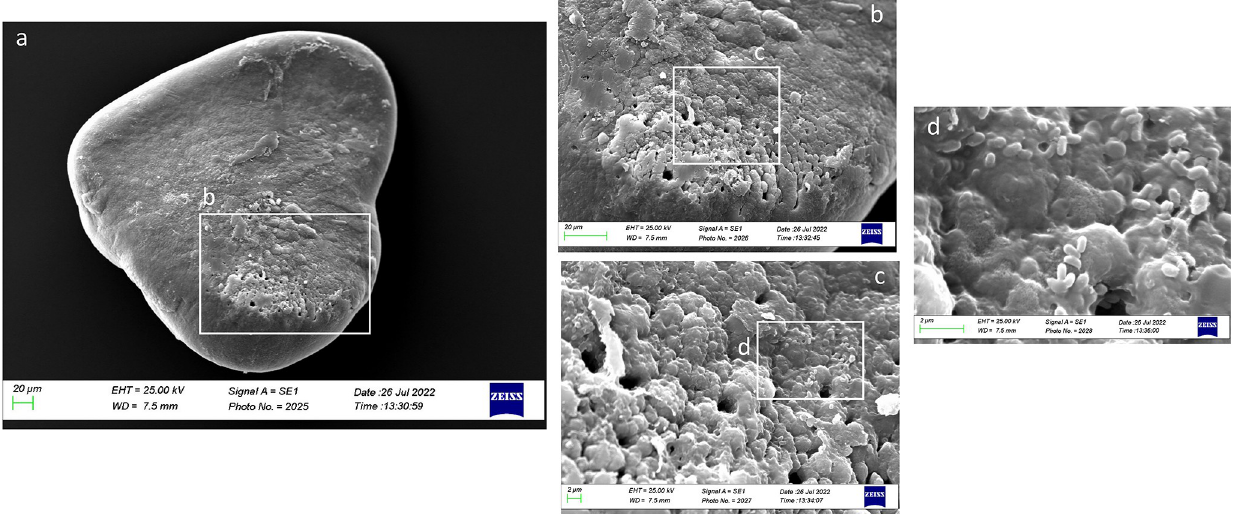
Fig 20. SEM images of a lapillus dorsal surface belonging to size Class III (a) with details of the external textural organization near the external margin (b, c).